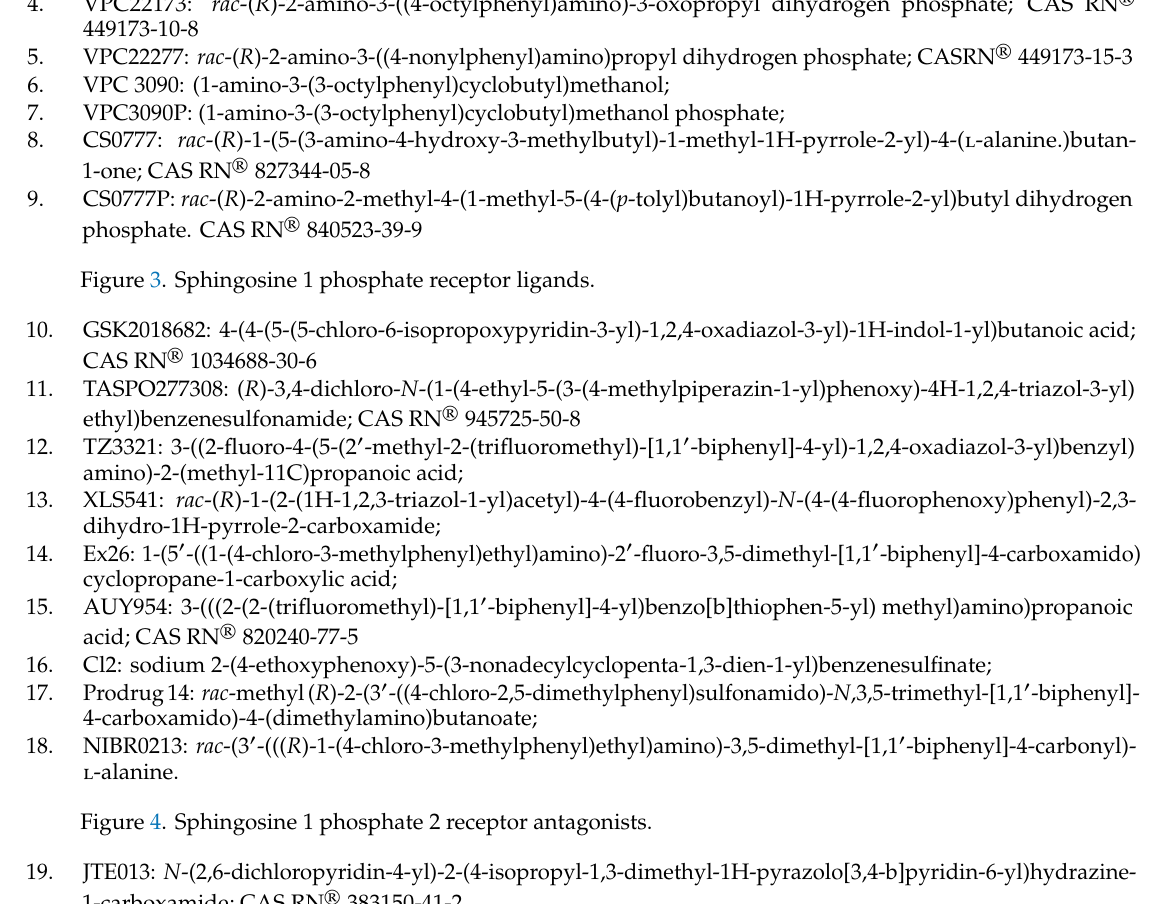
Figure 4. Sphingosine 1 phosphate 2 receptor